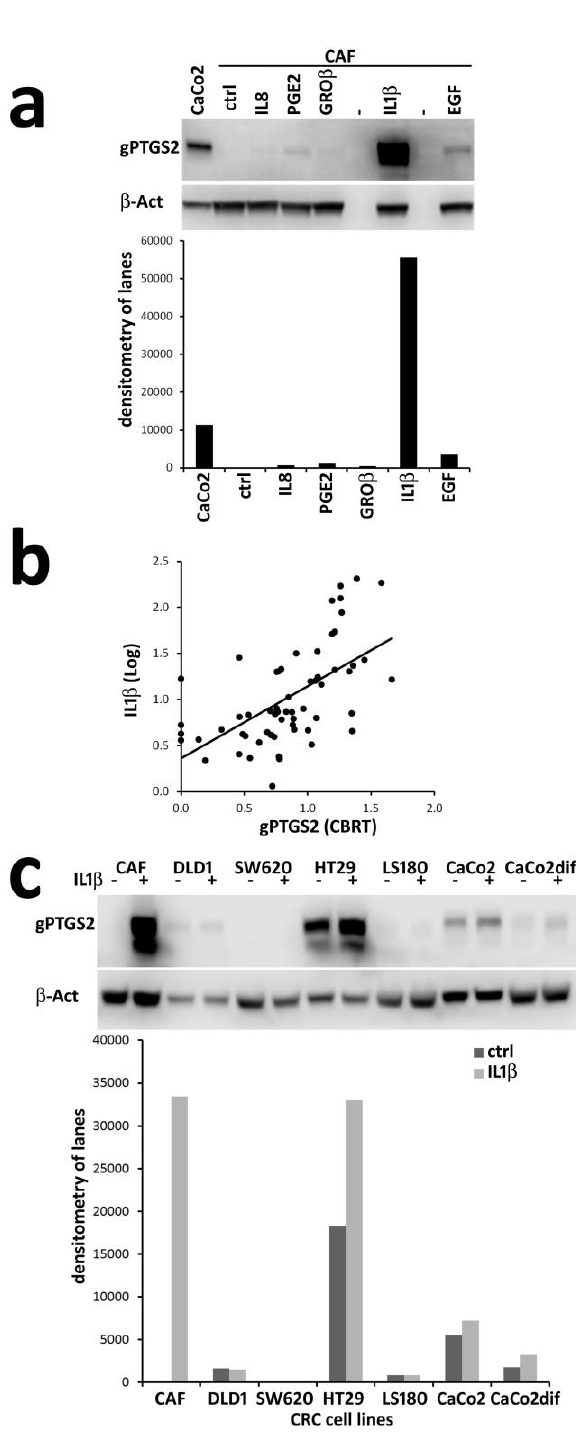
Figure 6. IL1 β strongly upregulates PTGS2 expression in cancer-associated fibroblasts (CAF) and correlates to gPTGS2 levels in tissue lysates: ( a ) The well-known PTGS2 inducer IL1 β and other four cytokines involved in CRC (CXCL8 / IL8, PGE2, CXCL2 / GRO β , and EGF; 24 h treatment) were tested as possible inducers of PTGS2 expression in primary CRC CAF. Only IL1 β induced a powerful response. Densitometric quantifications of WB lanes are plotted; ( b ) Linear regression of PTGS2 and IL1 β levels in CRC tissue lysates (60 samples). Pearson’s correlation coe ffi cient of gPTGS2 (CBRT = cubic root) vs. IL1 β (Log) levels was 0.593 (p = 0.00000609; ( c ) IL1 β (24 h treatment) has a reduced ability to modify PTGS2 basal expression in CRC cell lines. Densitometric quantifications of Western blot lanes are plotted. WB were run as experimental duplicates, with similar results (see Supplementary Figure S4).